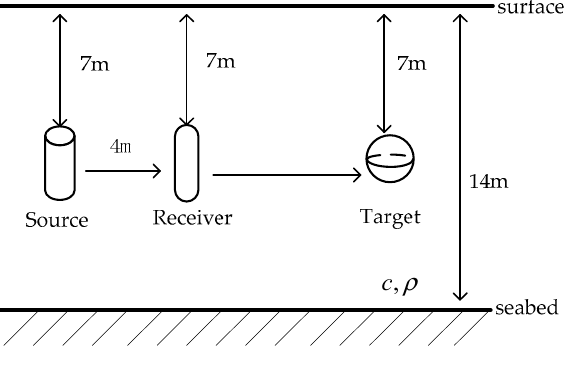
Figure 6. Schematic diagram of the experiment.